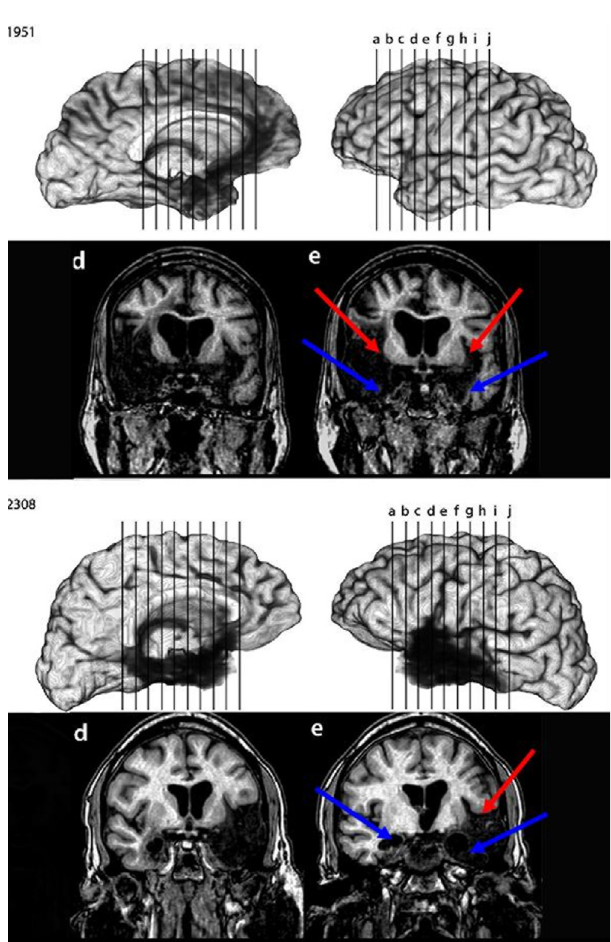
Figure 1 | MRI scans of post-encephalitic patients 1951 and 2308. Arrows point to regions of extensive tissue loss in the temporal